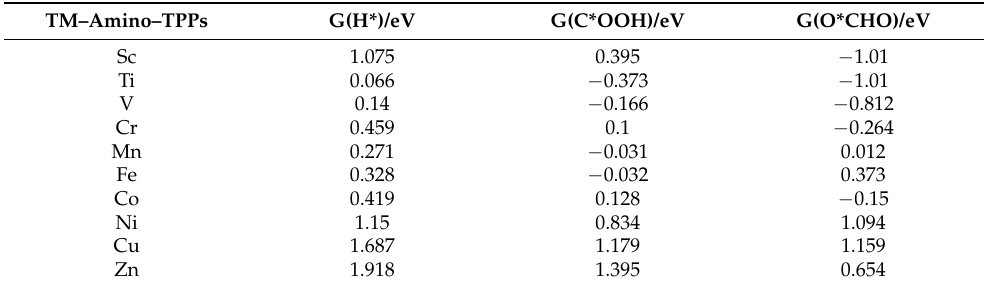
Table 3. The predicted values of G(H*), G(C*OOH), and G(O*CHO) from Equations (1B,2B,3B), respectively, for the newly designed transition-metal amino–porphyrin complexes (TM–Amino–TPPs, TM = Sc, Ti, V, Cr, Mn, Fe, Co, Ni, Cu, and Zn). TM–Amino–TPPs G(H*)/eV G(C*OOH)/eV G(O*CHO)/eV Sc 1.075 0.395 − 1.01 Ti 0.066 − 0.373 − 1.01 V 0.14 − 0.166 − 0.812 Cr 0.459 0.1 − 0.264 Mn 0.271 − 0.031 0.012 Fe −